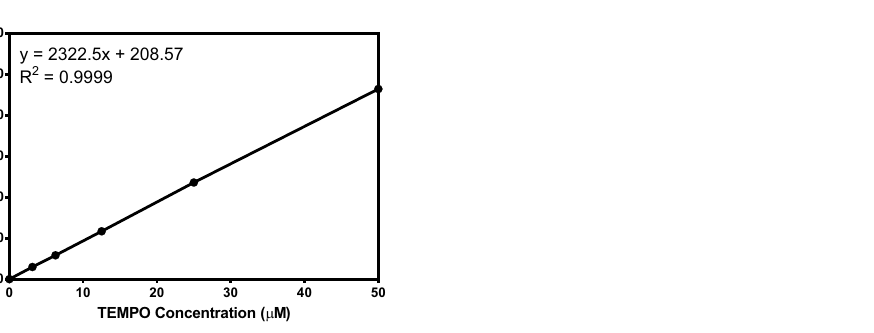
Figure 13. Calibration curve for the analysis of radical adduct using EPR. Double integration of TEMPO EPR spectra versus concentration of